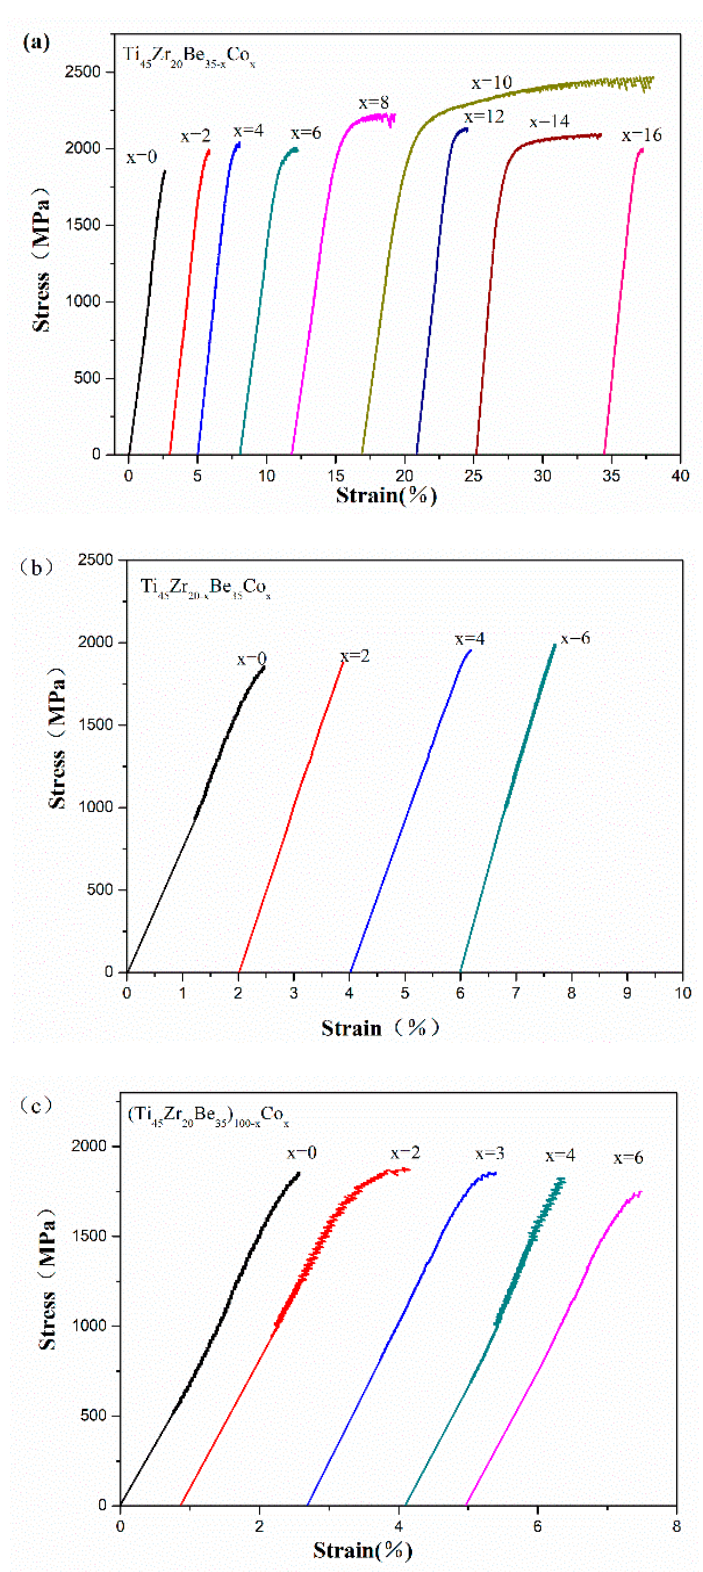
Figure 6. Compressive stress-strain curves of ( a ) Ti 45 Zr 20 Be 35 − x Co x ( x = 0, 2, 4, 6, 8, 10, 12, 14, and 16), ( b ) Ti 45 Zr 20 − x Be 35 Co x ( x = 0, 2, 4, and 6), and ( c ) (Ti 45 Zr 20 Be 35 ) 100 − x Co x ( x = 0, 2, 3, 4, and 6) samples.